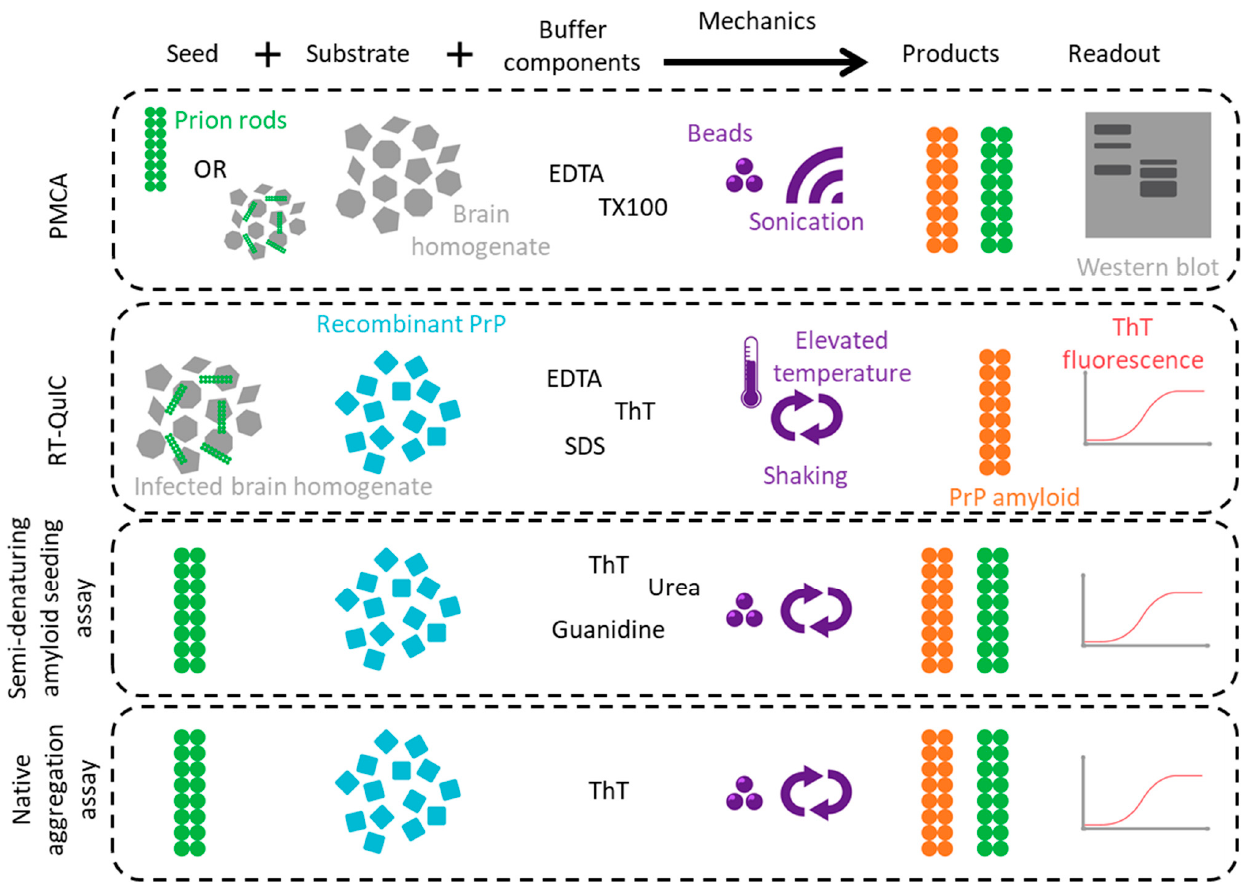
Figure 3. In vitro prion amplification assays. A direct comparison of the main in vitro aggregation methods, with regard to their respective components, conditions and outputs. Variations with regard to the starting seed and substrate, as well as how the final product is defined, are further discussed in the relevant section, but shown here is the typical set up for each.